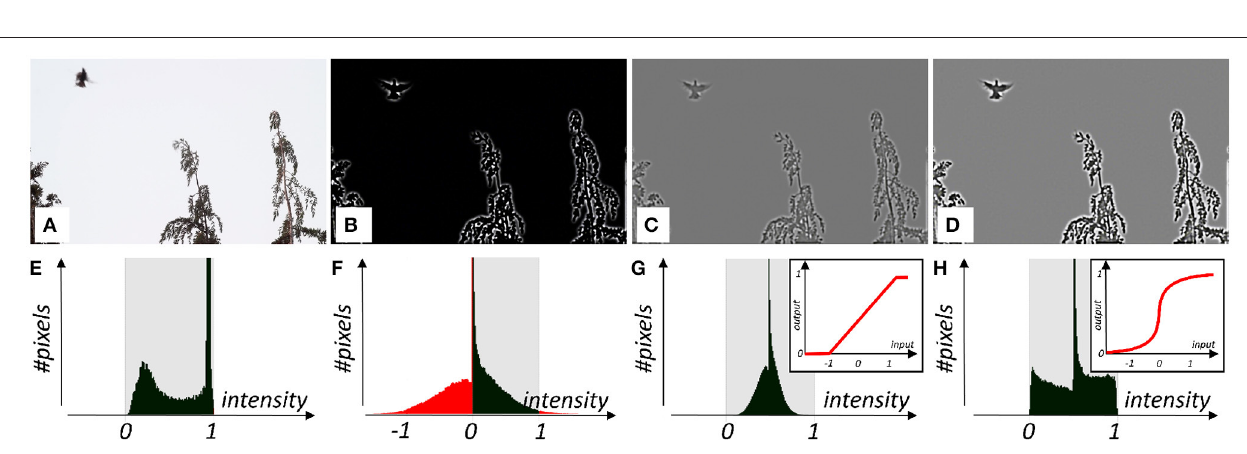
FIGURE 9 | Real-time filtering and subsequent tone mapping on a frame of a natural video: (A) unfiltered frame, (B) difference-of-Gaussians filtering applied, (C) subsequent tone mapping by linear transfer function, (D) subsequent tone mapping by sigmoidal transfer function. (E–H) Subfigures in the second row show respective histograms measured and displayed in GEARS. Histogram segments extending beyond the dynamic range [0 ... 1] are shown in red. These regions are “squeezed back” by the tone mapping transfer function to the dynamic range. Insets in the last two figures show the transfer functions used.